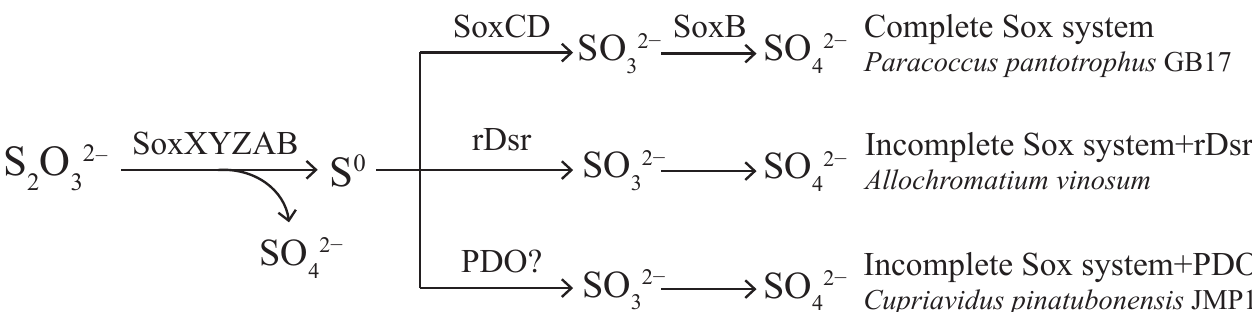
Figure 1. Currently known or proposed thiosulfate oxidation pathways related to the Sox system. There are two well known thiosulfate oxidation pathways related to the Sox system. The complete Sox system directly oxidizes thiosulfate to sulfate without intermediate production, where SoxCD is a sulfane dehydrogenase responsible for the oxidation of sulfane sulfur generated by the incomplete Sox system (SoxXA, SoxB, SoxYZ). Then, the oxidation product sulfite is oxidized to sulfate by SoxB. The Sox system widely exists in bacteria (top route). In another mechanism, rDsr (reversed dissimilatory (bi)sulfite reductase) oxidizes the sulfane sulfur produced by the incomplete Sox system to sulfite, which often exists in the phyla Proteobacteria and Chlorobi (middle route). Alternatively, this study proposed that PDO (persulfide dioxygenase) may work in concert with the incomplete Sox system to oxidize thiosulfate to sulfate, and PDO is widespread in bacteria (bottom route).